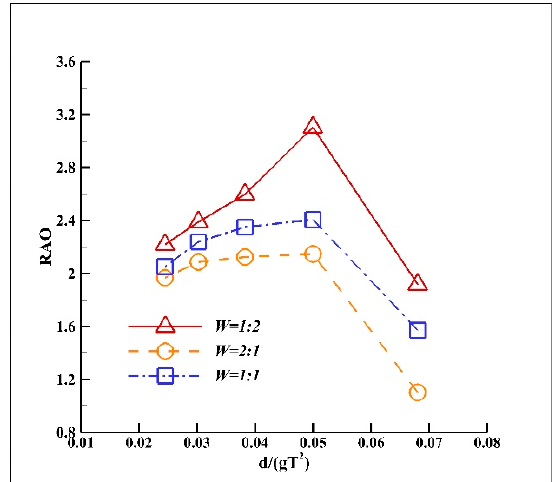
Figure 18. Effects of width ratio on hydrodynamic performance of the buoy (H = 0.1 m). Figure 18. E ff ects of width ratio on hydrodynamic performance of the buoy (H = 0.1